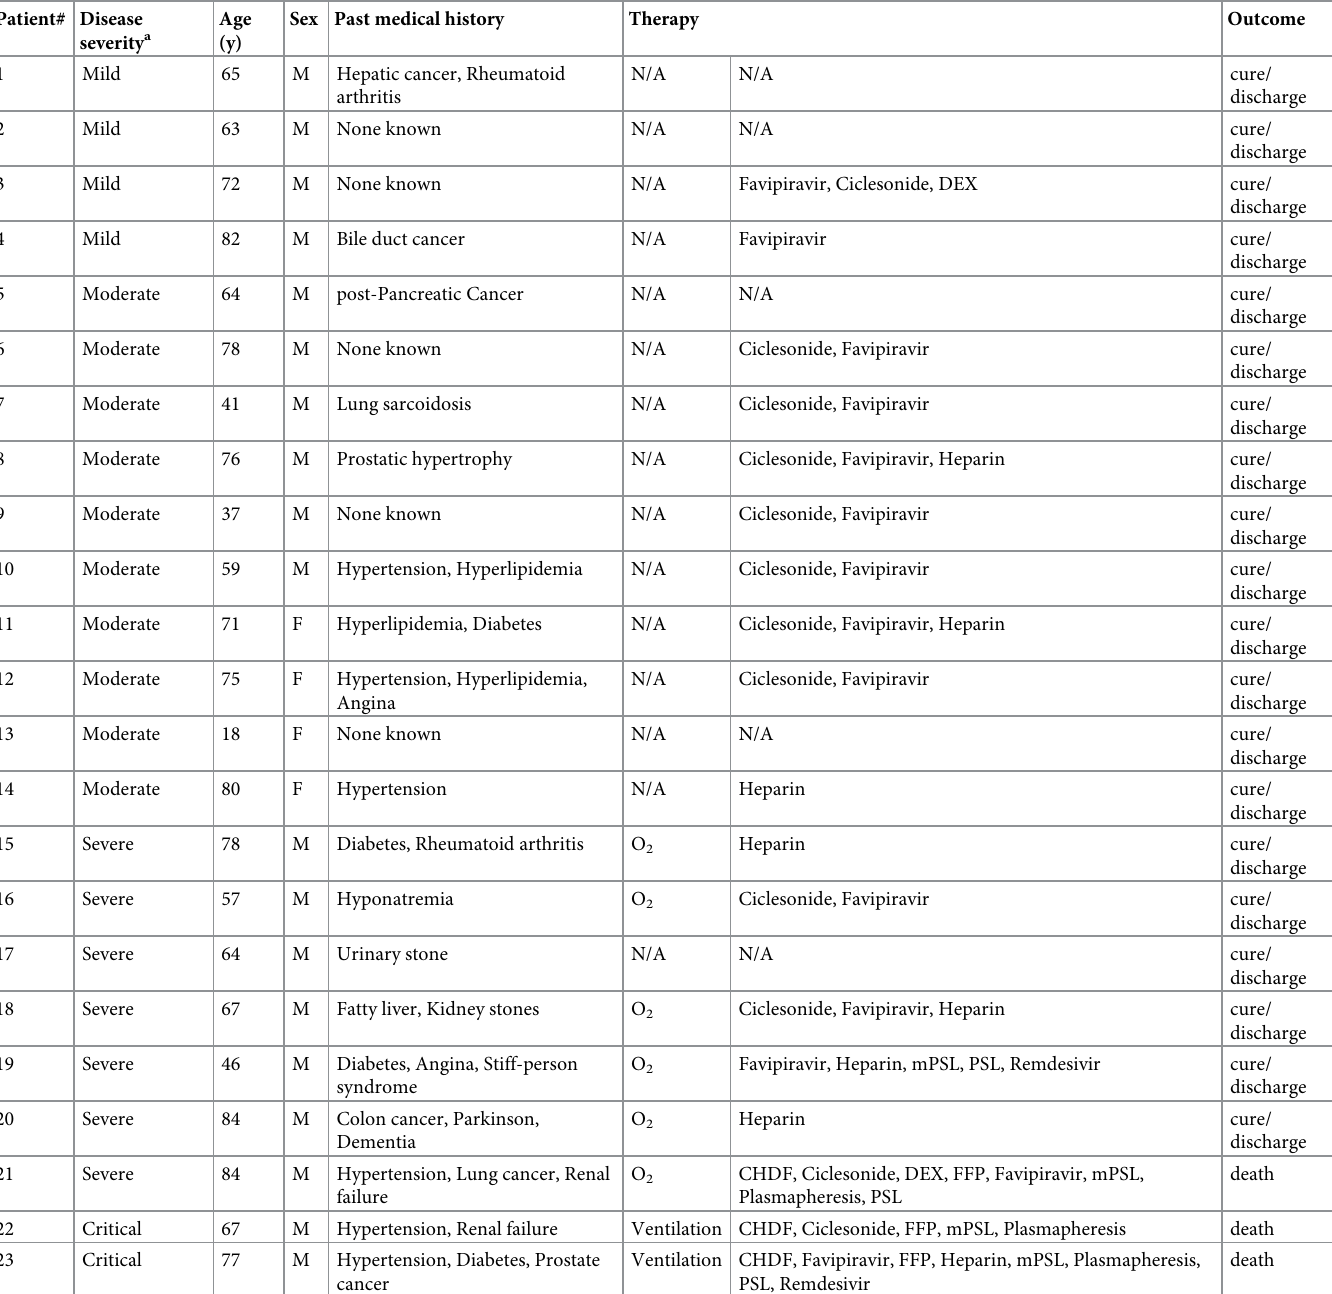
Table 3. Clinical characteristics of inpatients with